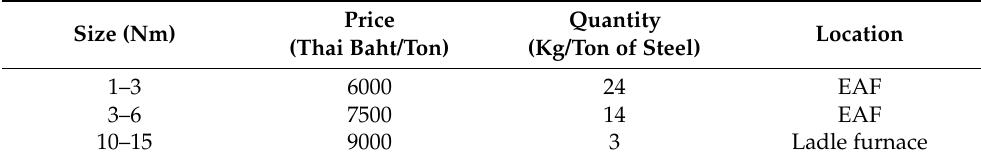
Table 10. The consumption of carbon in the process for UMC Metals Ltd.